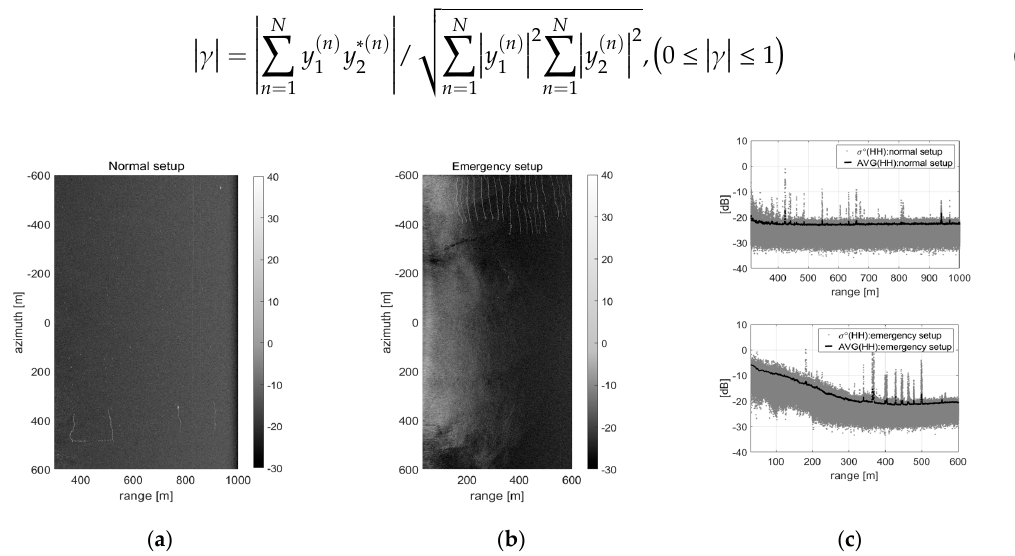
Figure 11. Comparison results of the sea surface SAR image applied the ‘shortened delayed-dechirp process’: on the left side, two images are the SAR images acquired by ( a ) normal setup and ( b ) emergency setup, and ( c ) are their range profiles of signal intensity, respectively.